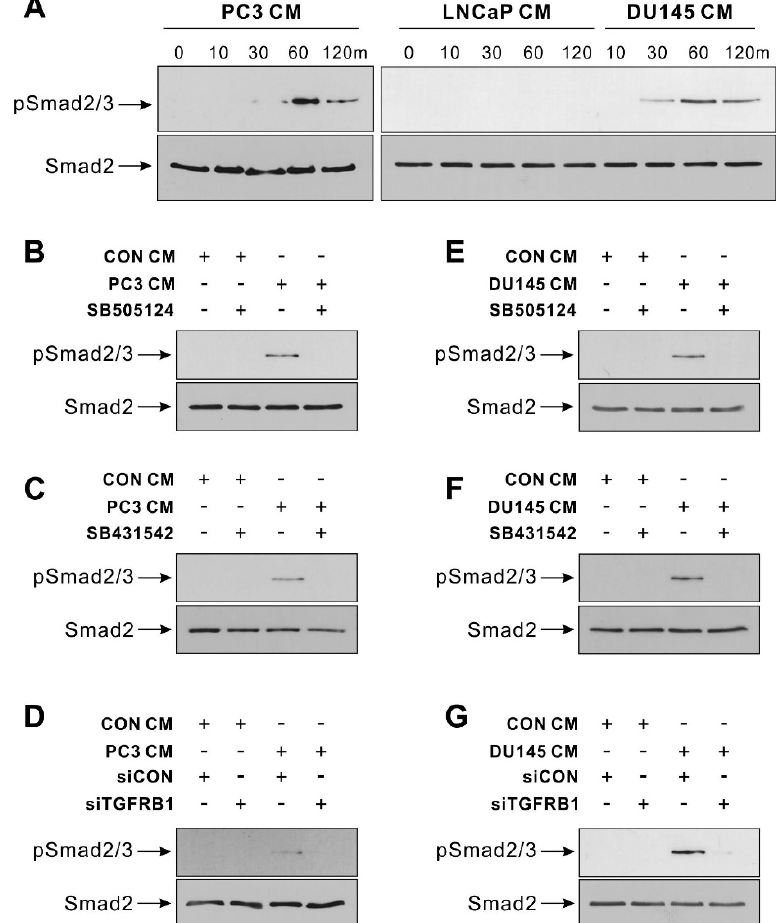
Figure 2. Hormone-insensitive prostate tumor cell-conditioned medium activates TGF- β signaling in bone marrow-derived mesenchymal stem cells (BM-MSCs). ( A ) Western blot analysis of phosphorylated Smad2/3 (p-Smad2/3) and Smad2. BM-MSCs were treated with the control-conditioned medium (CON CM), the PC3-conditioned medium (PC3 CM), the DU145-conditioned medium (DU145 CM), or the LNCaP-conditioned medium (LNCaP CM) for the indicated times. ( B , C ) Western blot analysis of p-Smad2/3 and Smad2 in BM-MSCs treated with SB505124 (5 µM) or SB431542 (10 µM) for 30 min prior to treatment with CON CM or PC3 CM for 60 min. ( D ) Western blot analysis of p-Smad2/3 and Smad2. BM-MSCs transfected with control siRNA (siCON) or TGF- β type 1 receptor (siTGFBR1) were treated with CON CM or PC3 CM for 60 min. ( E , F ) Western blot analysis of p-Smad2/3 and Smad2 in BM-MSCs treated with SB505124 (5 µ M) or SB431542 (10 µ M) for 30 min prior to treatment with CON CM or DU145 CM for 60 min. ( G ) Western blot analysis of p-Smad2/3 and Smad2. BM-MSCs transfected with control siRNA (siCON) or TGF- β type 1 receptor (siTGFBR1) were treated with CON CM or DU145 CM for 60 min. Uncropped Western blot images are available in Figure